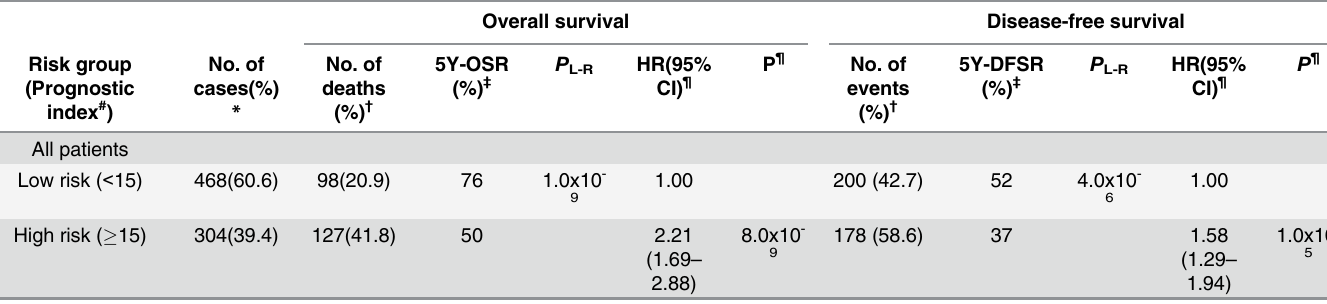
Table 3. Combined effect of 8 SNPs on overall survival and disease-free